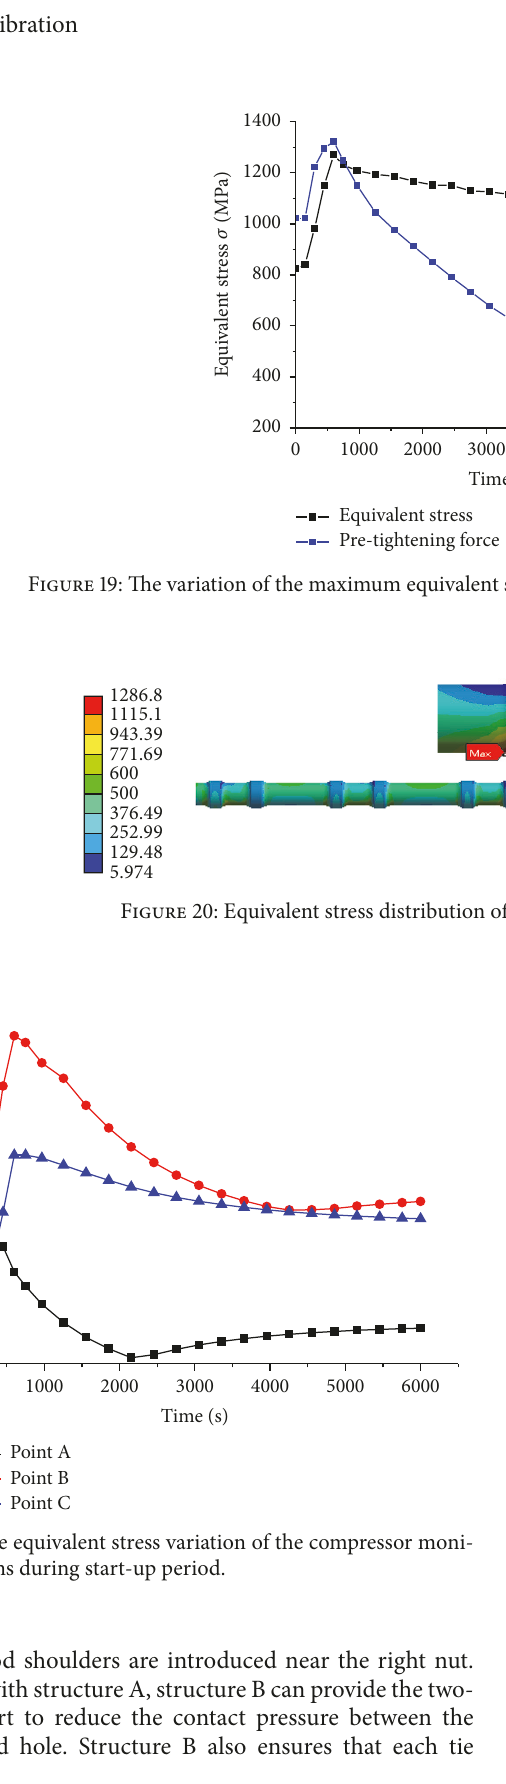
rod hole corresponds to double shoulders. For the double shoulder structure, the contact pressure on the single shoul- der is reduced, and the compressional deformation between the shoulder and hole decreases with the contact